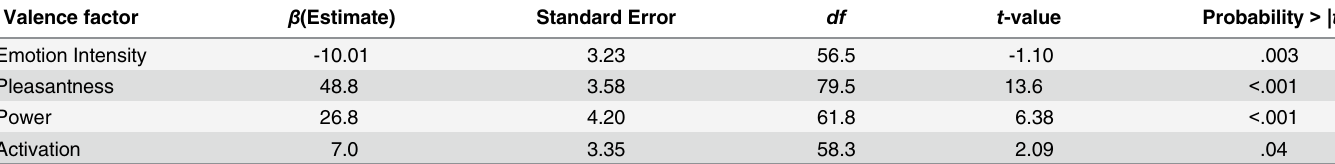
Table 6. Results from continuous measures analyses: Affect burst condition. Valence